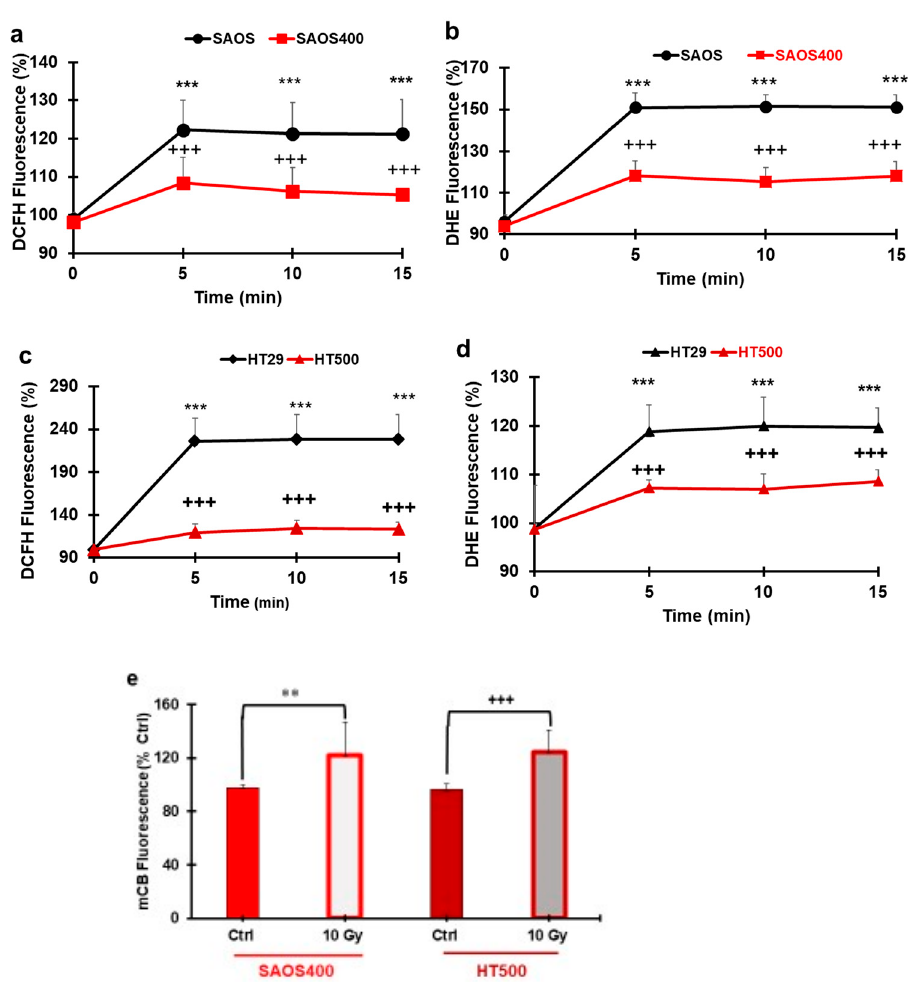
Figure 5. ROS and GSH production in SAOS400 and HT500 cells. SAOS/SAOS400 and HT29/HT500 (panels a and c ) cells were pre-incubated with H 2 O 2 probe (CM-DCFDA) or O 2 − probe (DHE) (panels b and d ), washed, and irradiated (10 Gy). Fluorescence was measured in the 5–15 min time range. Data reported are the mean ± SD of three independent experiments in quadruplicate. Symbols indicate significance after ANOVA analysis for multiple comparisons at different time points: *** p ≤ 0.001 of SAOS400 and HT500 cells vs. their parental cell lines; +++ p ≤ 0.001, indicate significance of SAOS400 and HT500 cells at times 5–15 min vs. time 0 min. In panel ( e ), the GSH levels in SAOS400 and HT500 cells after 10 Gy for 2 h are reported. Cells were incubated with a GSH intracellular probe (mCB), as described in the Methods section. Bar graphs represent the mean ± SD of three independent experiments in quadruplicate. Symbols indicate significance: ** p < 0.01 untreated SAOS400 cells vs. irradiated; +++ p < 0.001 untreated HT500 vs. irradiated.